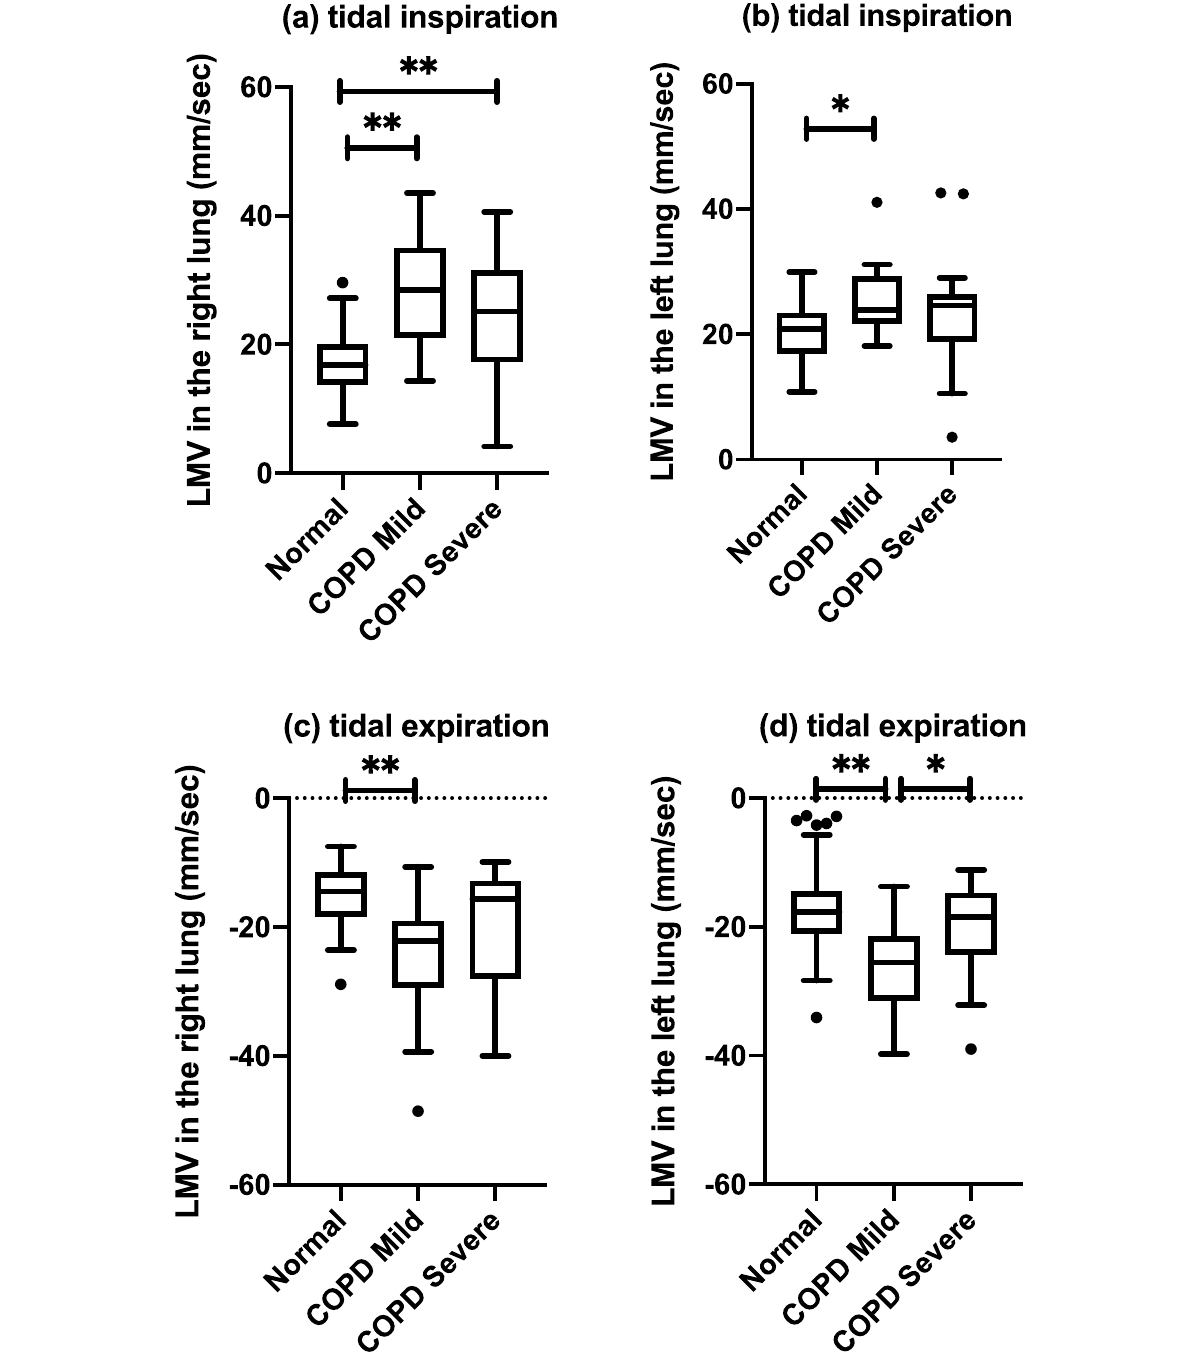
Fig. 6 Box-and-whisker plots of bilateral LMV of normal, COPD mild, and COPD severe groups in the tidal respiration. In each phase, differences between groups were investigated using one-way analysis of variance on ranks. Multiple comparisons showed that the absolute value of LMV of the COPD mild group was larger than that of the normal group with statistical significance. * p < 0.05; ** p < 0.01. COPD Chronic obstructive pulmonary disease, LMV Lung motion